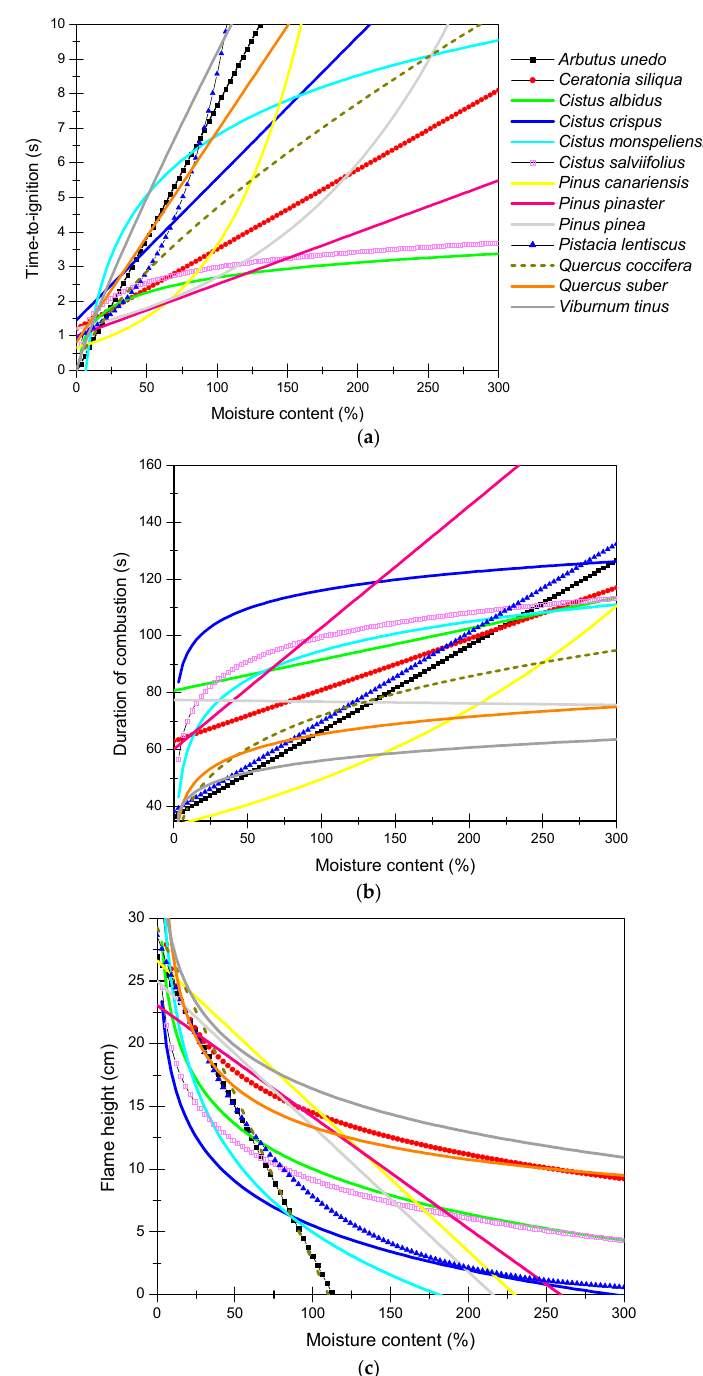
Figure 2. ( a ) Average values of time-to-ignition; ( b ) duration of combustion and ( c ) flame height by species according to fuel moisture content.